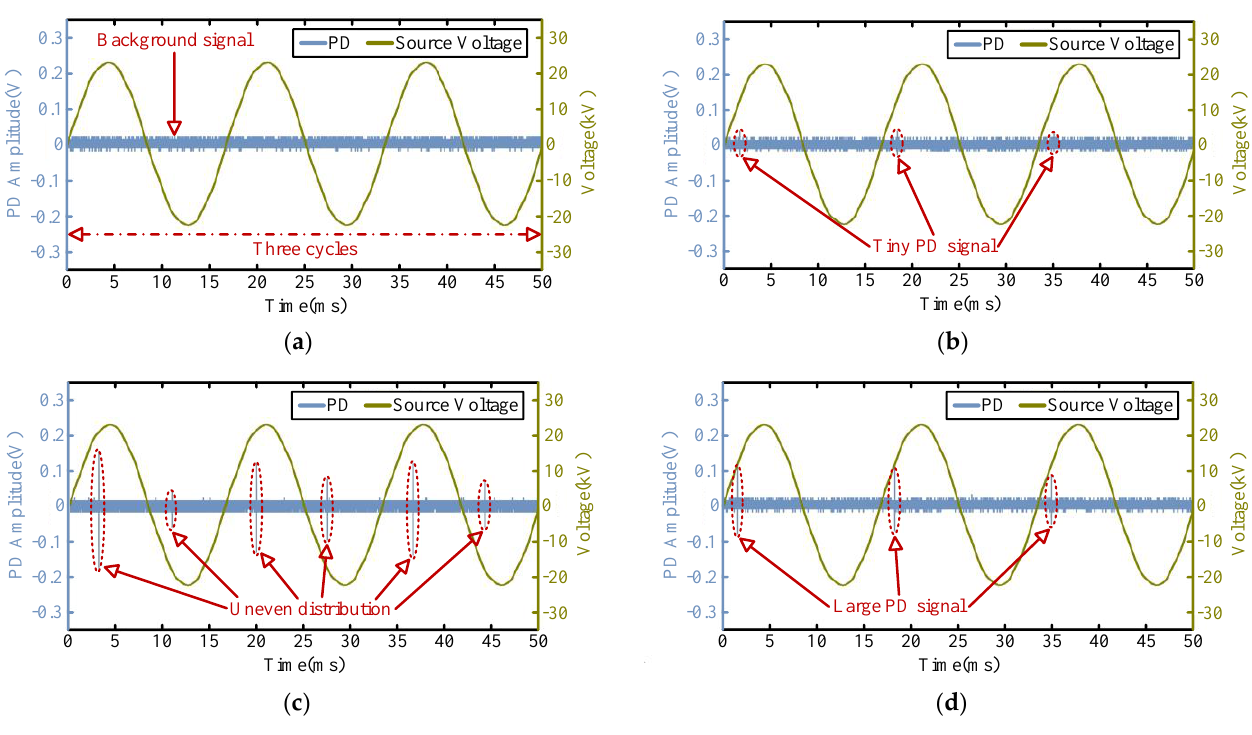
Figure 11. Power cable PD signals of different insulation defects. ( a ) Normal power cable; ( b ) power cable outer semi-conducting layer defect; ( c ) power cable insulation with impurities; ( d ) power cable insulation damage defect.